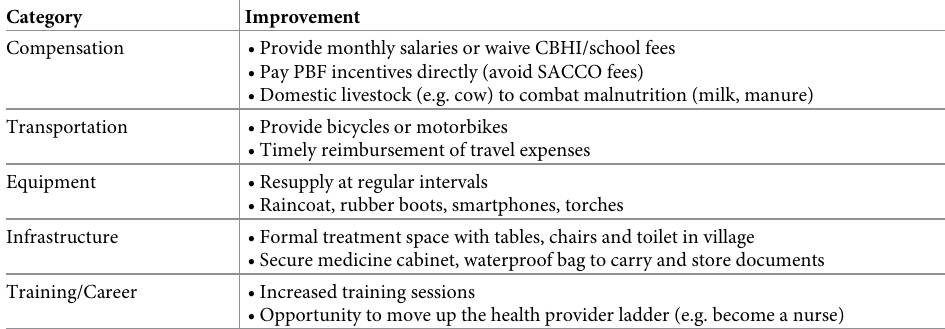
Table 5. Community Health Worker suggestions for improving patient and provider